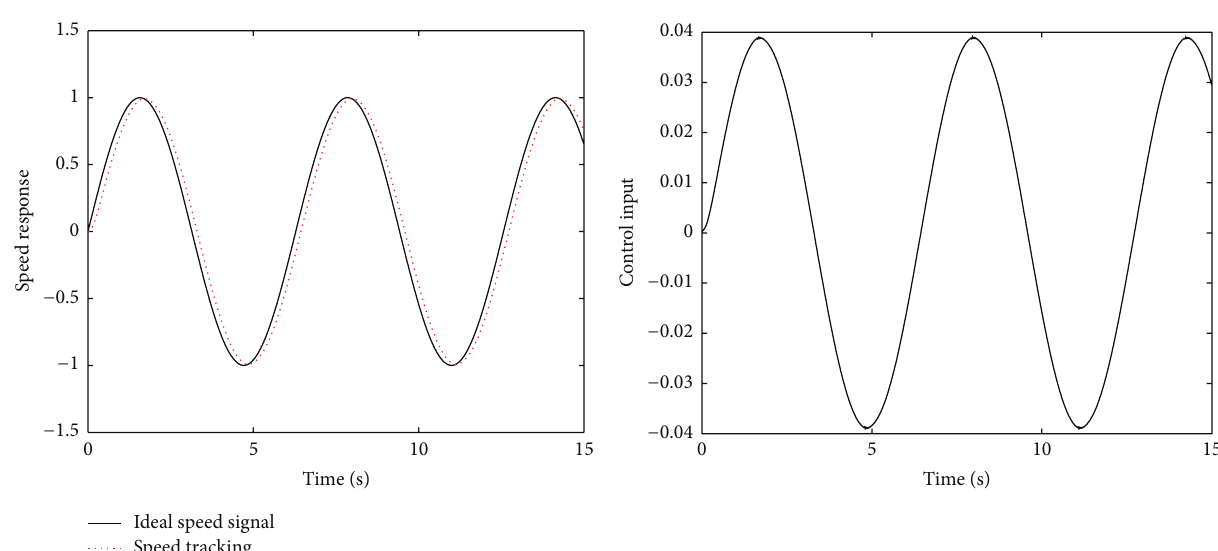
Figure 14: Simulation curve based on sliding mode control at variable